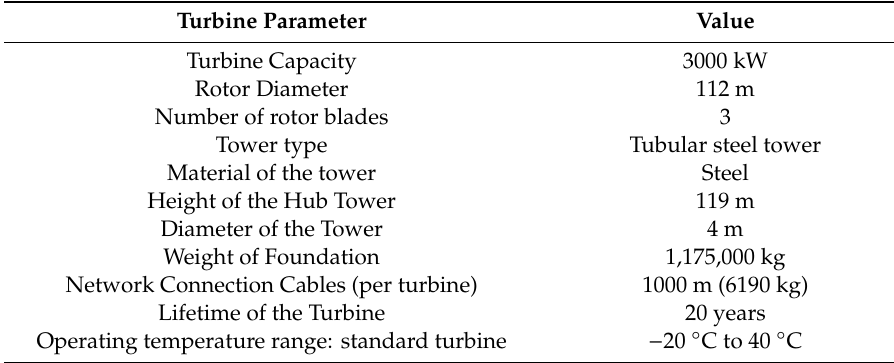
Table A1. Turbines Component Measurements and